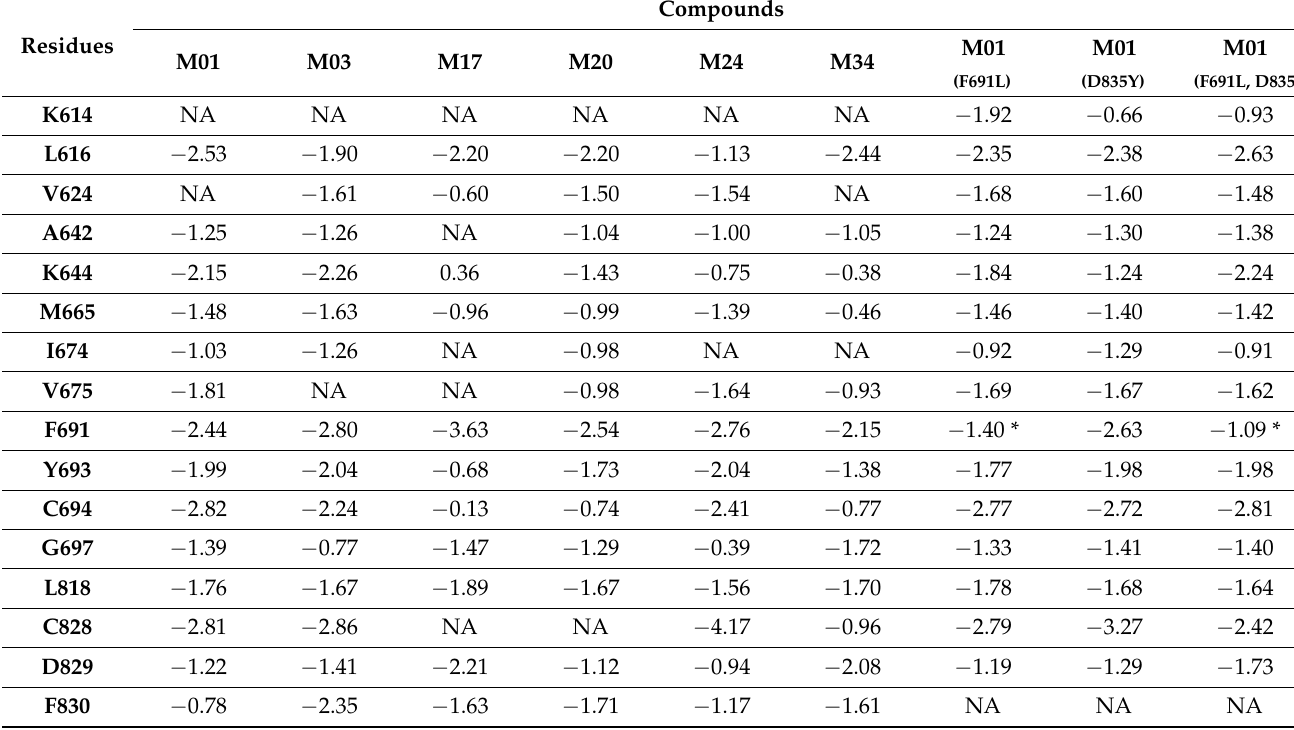
Table 2. Per-residue MM-PB(GB)SA ∆ TOTAL binding free energy decomposition in kcal/mol.